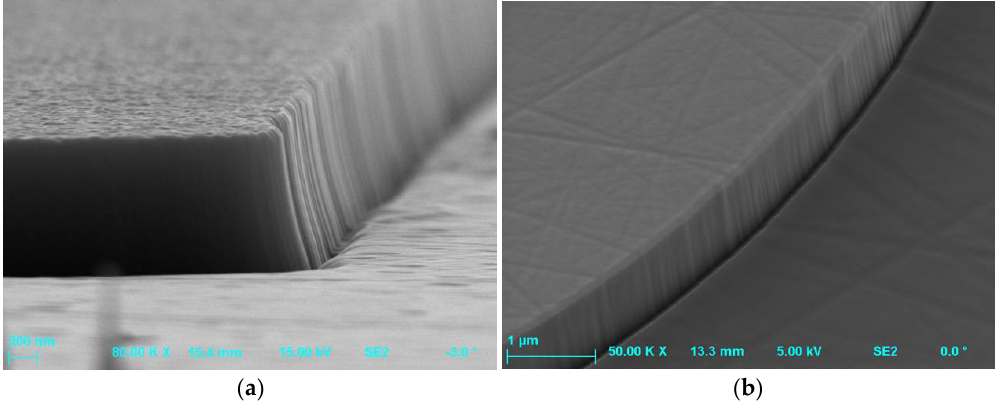
Figure 4. SEM profiles of SiC MESA structures with microtrenches (unevenness on walls of etched profiles) obtained after etching processes: ( a ) O 2 flow rate = 2 sccm, SF 6 flow rate = 20 sccm, P RIE = 100 W, P ICP = 1300 W, p = 5 mTorr, t = 12 min; ( b ) O 2 flow rate = 50 sccm, SF 6 flow rate = 50 sccm, P RIE = 50 W, P ICP = 2500 W, p = 7 mTorr, t = 5 min.